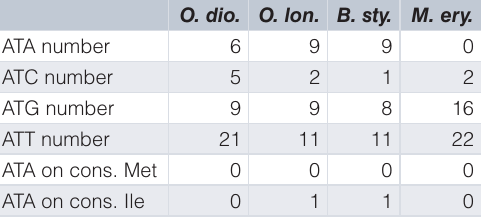
ATA on cons. Met